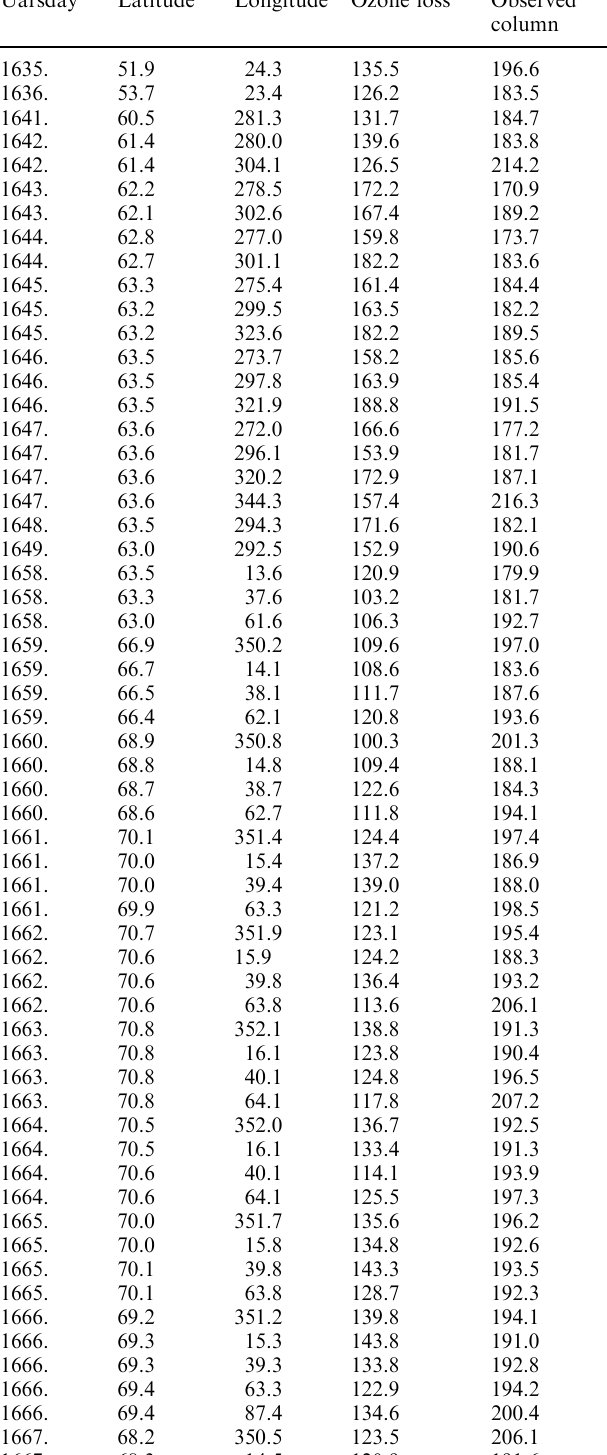
Table 1. HALOE observations inside the polar vortex in March and April 1996. In the table location, potential vorticity (in potential vorticity units, at 550 K potential temperature), calculated ozone loss (for the altitude range 350–550 K; 150–25 hPa) and the measured ozone column (above 100 hPa) (both in Dobson units (DU)) of all HALOE observations in the vortex in March and April 1996 is listed. (The date is given as uarsday, e.g. uarsday 1635 is March 3, 1996 and uarsday 1664 is April 1,